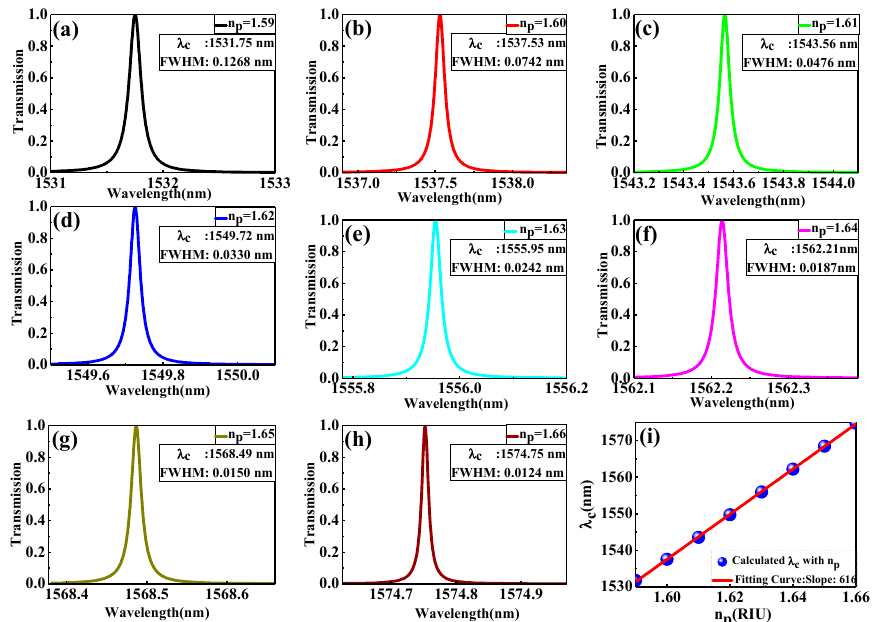
Figure 6. ( a – h ) The transmission spectrum as a function of the resonance wavelength due to changing EO polymer refractive index n p from 1.59 to 1.66 with an increment of ∆ n p = 0.01; ( i ) the resonance wavelength shifting ∆ λ as a function of n p variation where the simulated data is characterized by the blue sphere and the linear fitting by the red solid line.